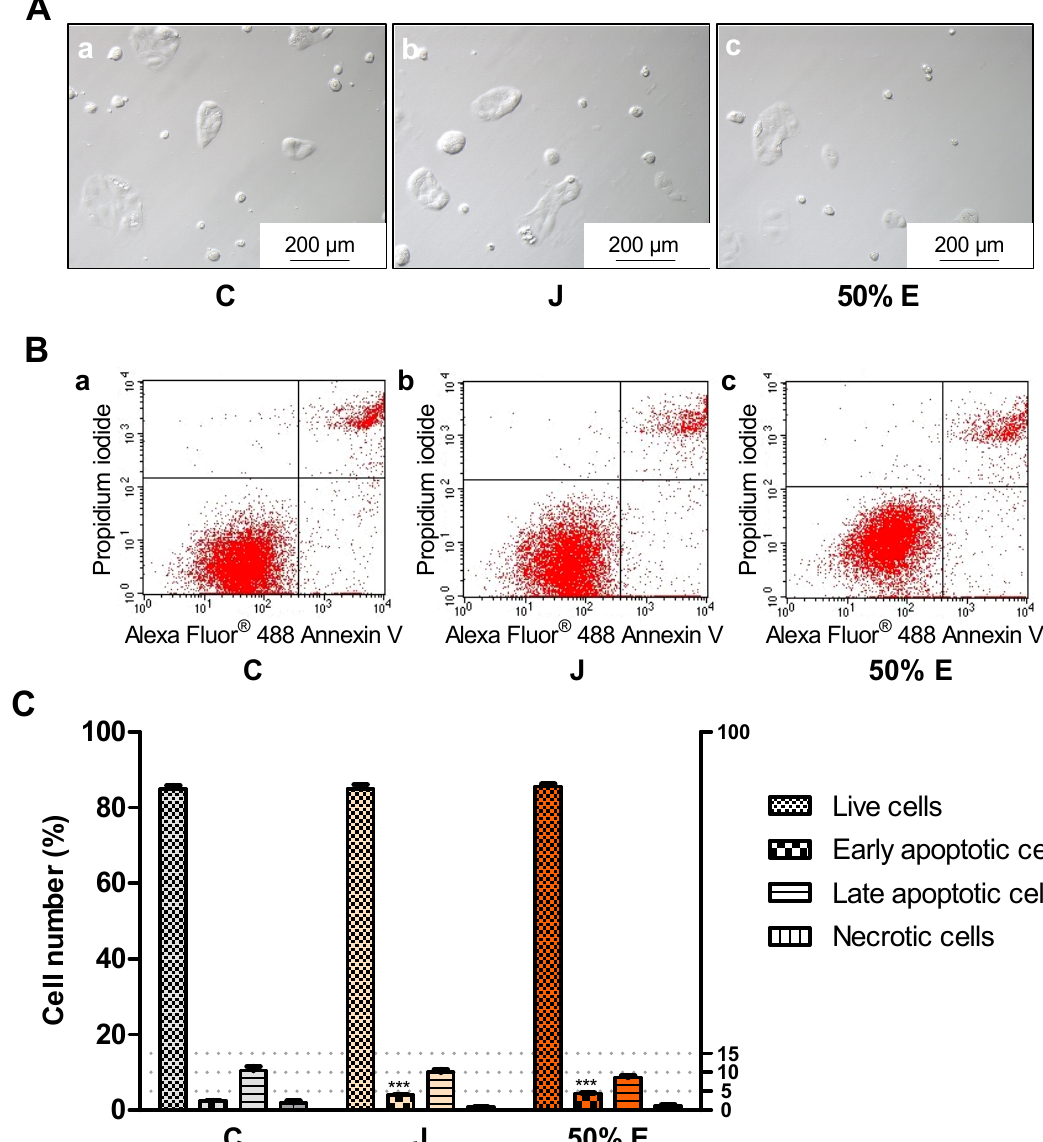
Figure 6. Types of death of Caco-2 cells after 24 h of treatment with juice (J) and 50% hydroethanolic extract (50% E) from Saposhnikovia divaricata root, at the concentration of 15.9 × 10 − 1 mg / mL. C—control cells (treated with deionized water). Panel ( A )—images from light microscope, panel ( B )—exemplary flow cytometry charts (lower left quadrant–live cells, lower right quadrant–early apoptotic cells, upper right quadrant–late apoptotic cells, upper left quadrant–necrotic cells), panel ( C )—graphs with error bars indicating standard error of the mean. Statistically significant effect: *** represents values that differ from control at p < 0.001. n = 6.